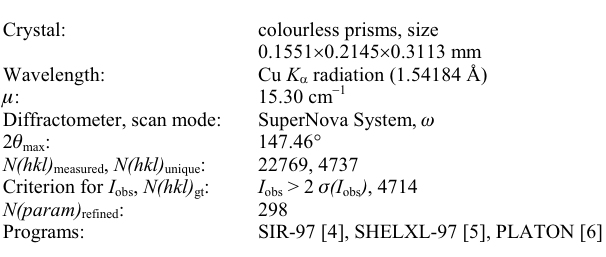
Table 1. Data collection and handling.